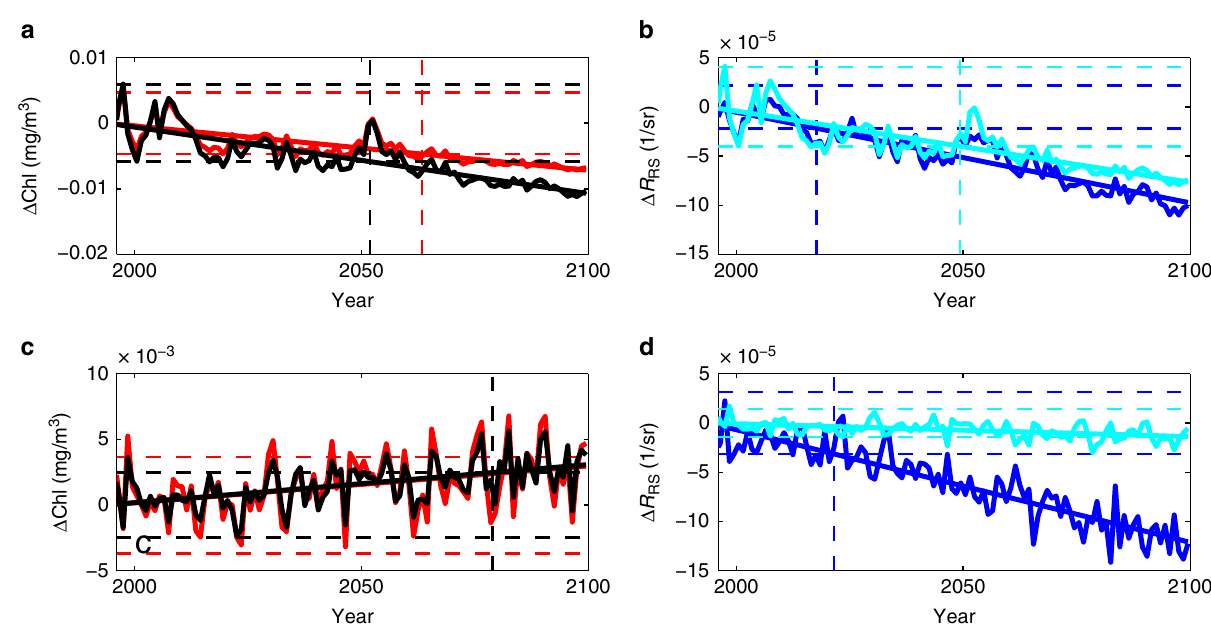
Fig. 8 Time series of changes in two locations. a , b are in the North Atlantic, indicated by circle in Fig. 4. c , d are in North Paci fi c, indicated by cross in Fig. 4. a and c show the changes in model actual Chl-a (black) and model Chl-a product derived from re fl ectance ratio (red); b , d show changes in R RS for 475 nm (dark blue) and 550 nm (light blue). Straight solid lines indicate the linear trend using generalized least squares (GLS), the dashed horizontal lines indicate plus and minus two standard deviations (STD) of the interannual variability from 1998 to 2015, and the vertical dashed line shows the time of emergence (trend > twice the STD)